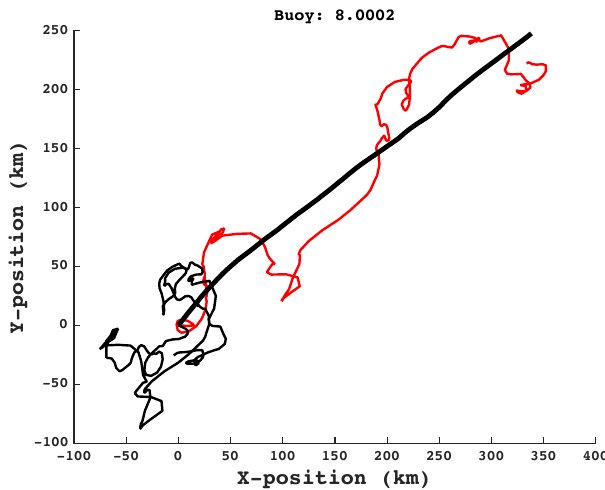
Figure 1. Example of a 35-day long trajectory from a buoy of the IABP dataset (thin red line) partitioned into a mean (thick black line) and fluctuating (thin black line) parts using the method described in Sect. 2.2 and the averaging scales L = 400km and T = 150 days. The starting point of the three trajectories is the same and arbitrarily set to be the origin of the axes.